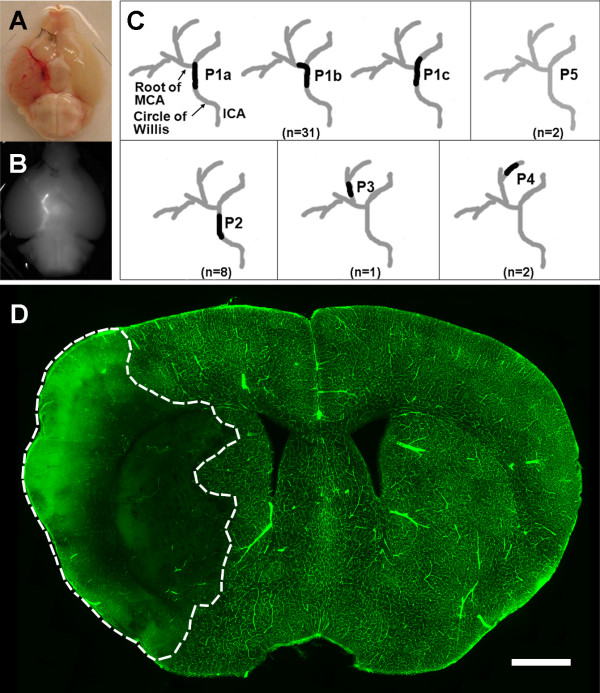
Patterns of embolus blocking the MCA. a A representative picture showing the site of the embolus blocking the right MCA at the circle of Willis. After injection of clot, mice were transcardially perfused with saline and the brain was removed. b The position of embolus was confirmed by injection of clot labeled with fluorescent dye, marking blockage of the right MCA. c Identification of embolus positions (P) in brain 24 hours after ischemia. P1 (P1a–P1c together) indicates complete blockage of the MCA, P2 indicates that an embolus did not reach the MCA, P3 indicates that an embolus was lodged in the second branch of the MCA, P4 indicates that an embolus was lodged in the third branch of the MCA, and P5 indicates that no embolus was seen. Number of animals (n) in each position is shown in parenthesis. d Validation of embolus-induced MCA blockage by FITC-dextran infusion. A representative coronal section from a brain after venous infusion of FITC-dextran showing infarct area in the right MCA supplied regions (marked by dashed white lines) 24 hours after embolus-induced ischemia. Perfusion of FITC-dextran marks the microvessels in the unlesioned brain regions. In the peripheral part of the infarct cortex, high intensity of FITC-dextran indicates leakage of the 2,000 kDa macromolecule from microvessels into the infarct area. Section thickness, 100 μm; Scale bar, 800 μm.